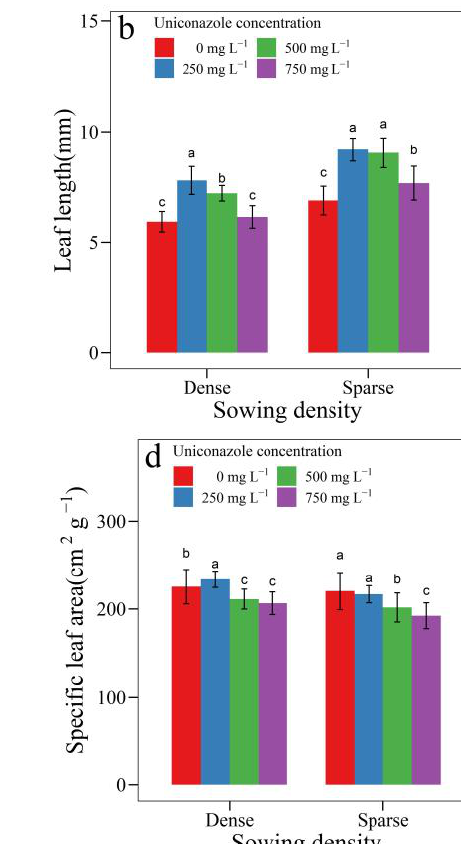
Figure 1. The effect of uniconazole on seedling architecture in two sowing densities. Values are the seedling architecture measured at 30d of seedling height ( a ), seedling width ( b ), height per diameter ( c ), stem length ( d ), and stem diameter ( e ). Sparse and dense represent sowing densities of 400 and 800 seeds per tray, respectively. Significant effects ( p ≤ 0.05) are shown by different letters in the same sowing density.